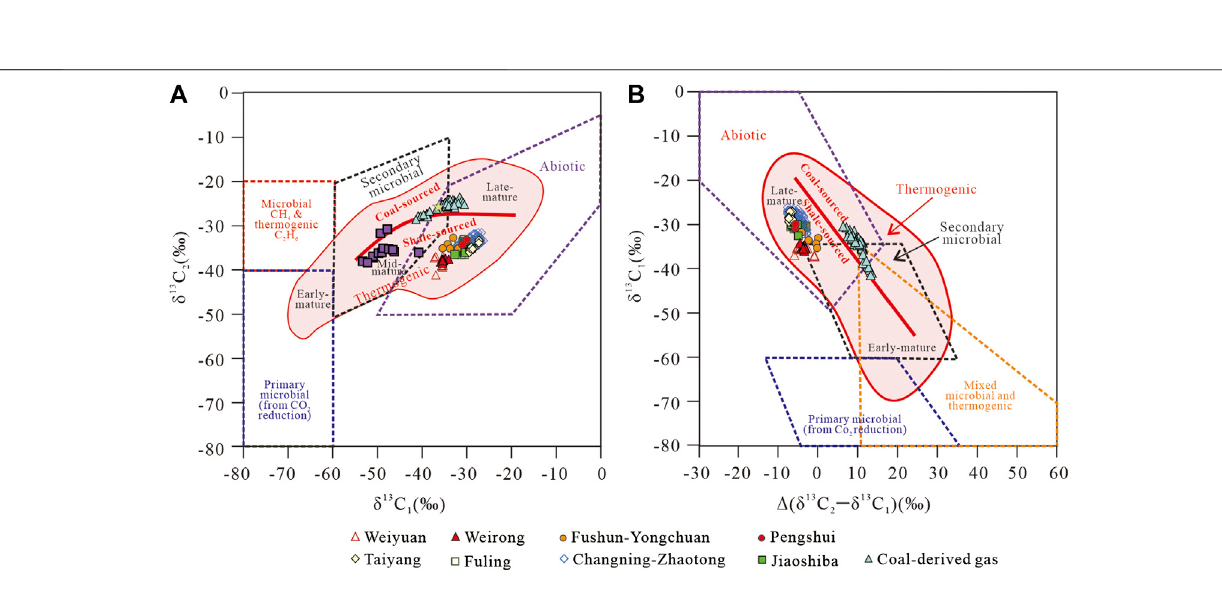
Frontiers in Earth Science |